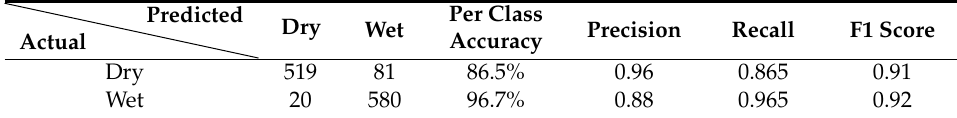
Table 4. Confusion matrix for road conditions